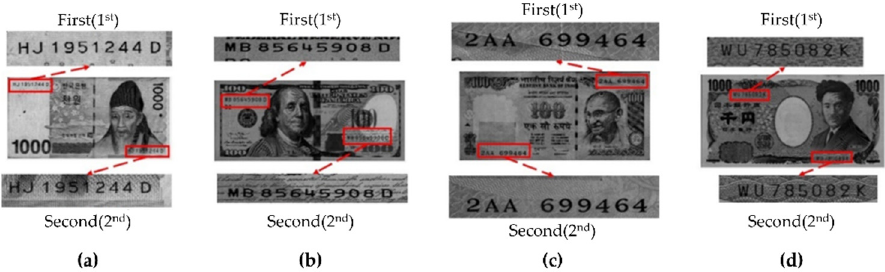
Figure 4. Example of ROI selections for different positions of the banknote serial number: ( a ) KRW; ( b ) USD; ( c ) INR; ( d ) JPY.